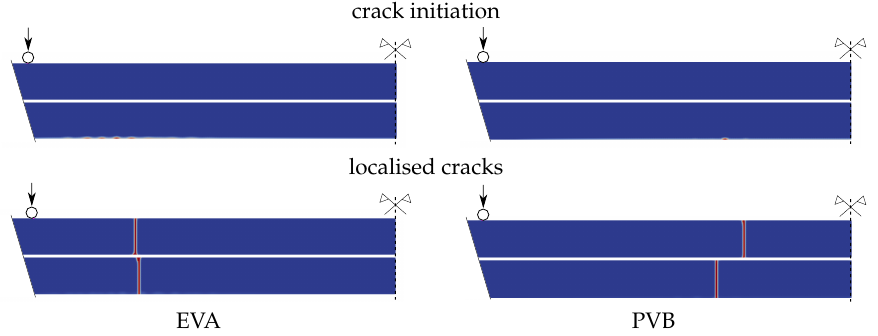
Figure 17. PF-P formulation, anisotropic staggered approach with the spectral-decomposition split, PS model: Crack initiation and localised crack laminated glass samples under four-point bending.